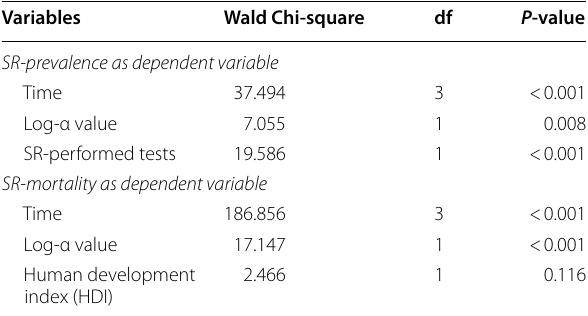
Table 3 Results of generalized estimation equations for investigation of associations of prevalence and mortality of COVID-19 with the α-values as frequency of consanguineous marriages in the 65 countries around the